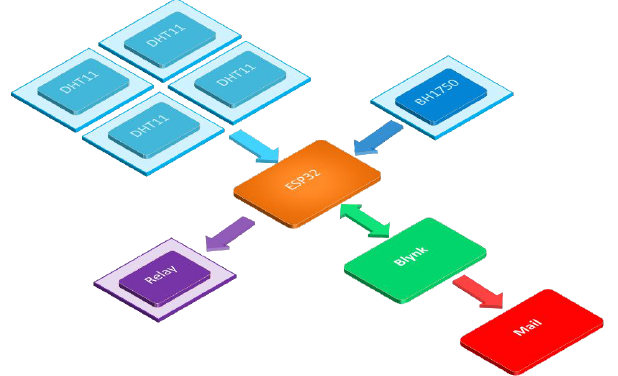
Figure 3. Data transmission diagram of the plant nursery control system.